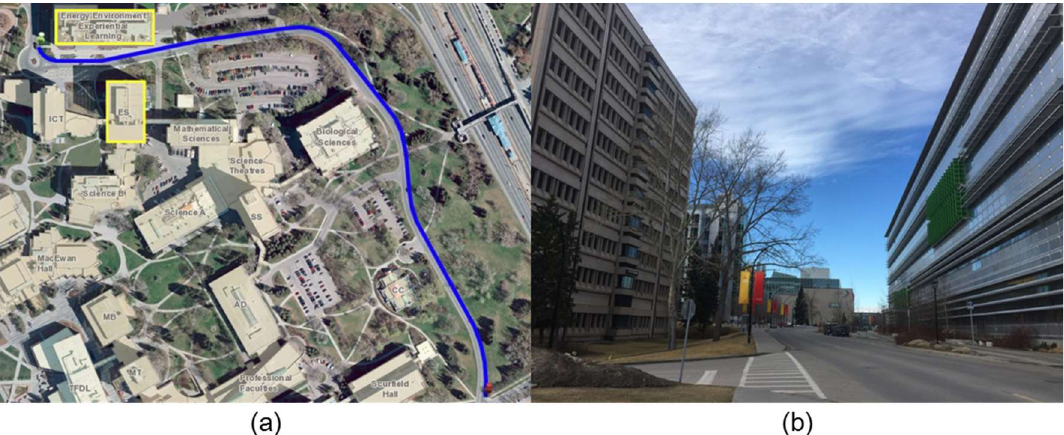
Figure 4. ( a ) Trajectory of dataset no. 3 represented as a blue line on the main road at the University of Calgary, where the EEEL and ES buildings are marked with yellow rectangles. The green and red points denote the starting point and finishing point, respectively; and ( b ) the test environment between the EEEL and ES buildings.